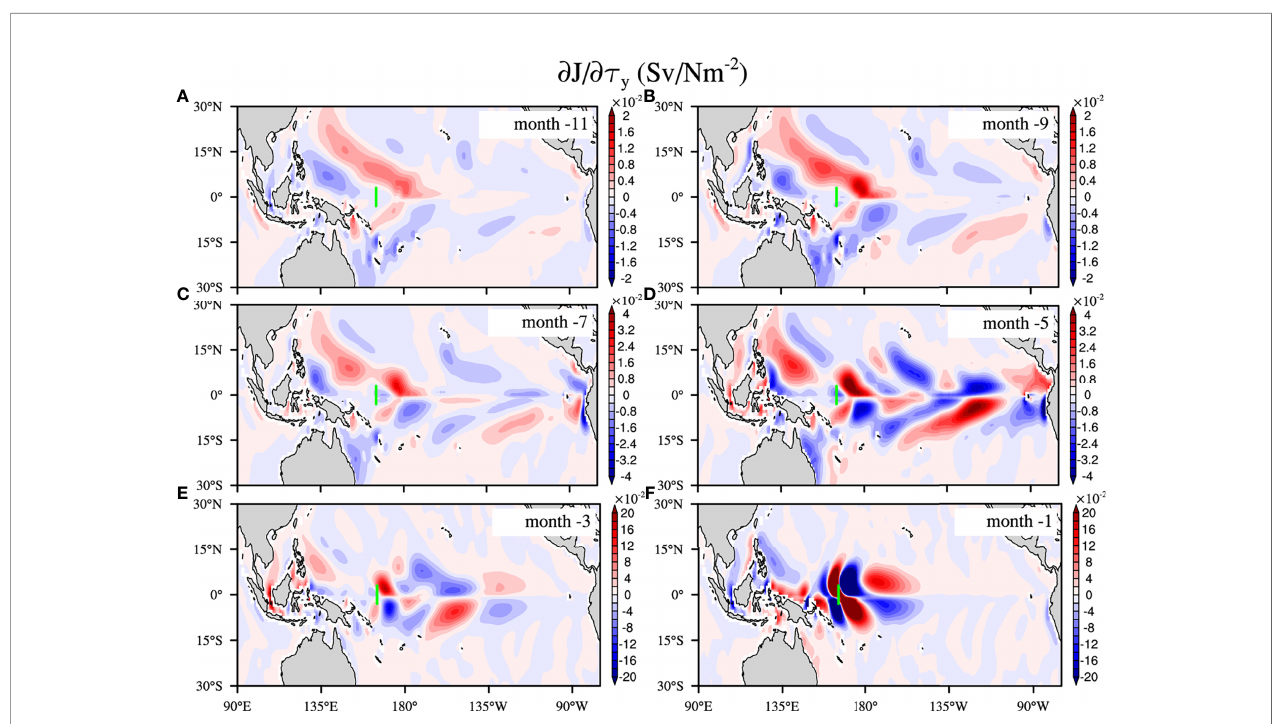
FIGURE 4 | Same as Figure 3 , but for meridional wind stressfrom previous 11 to 1 months (marked as A – F ,